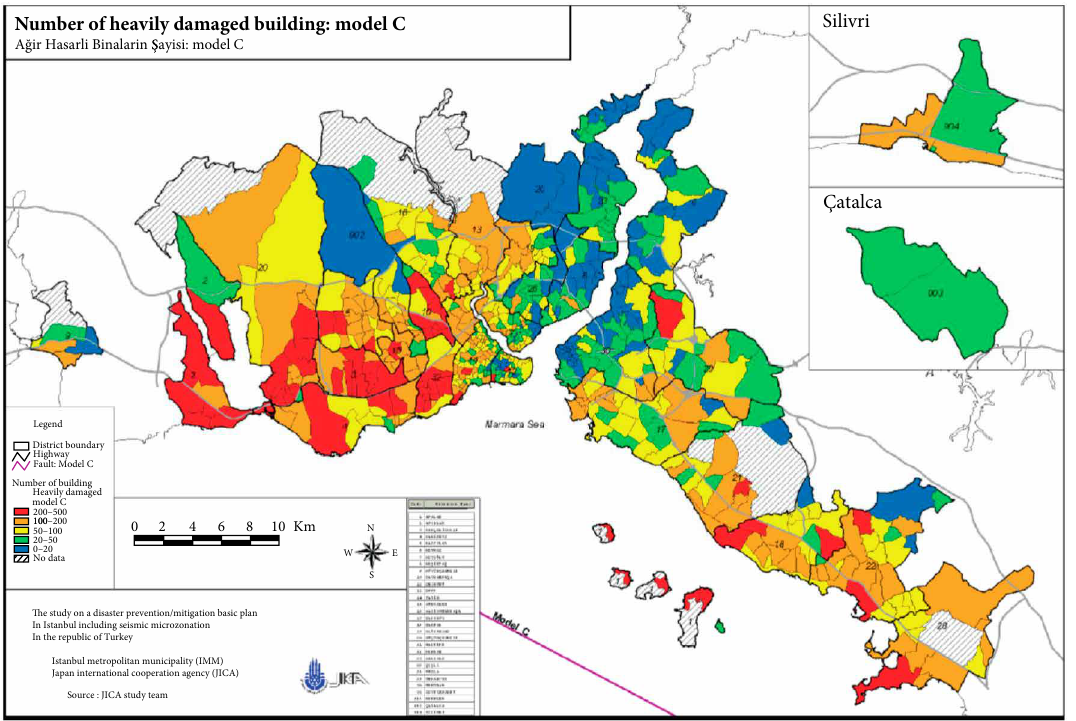
Figure 2: Number of heavily damaged buildings in model C